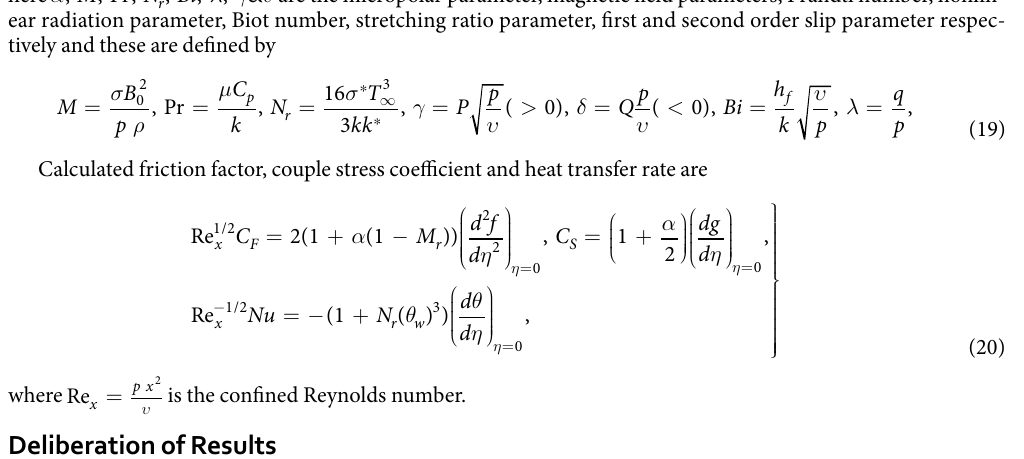
g (0), (0) but a contrary development is noticed for second order slip parameter. Also, the thermal transport rate is a cumulative function of second order slip parameter but an inverse outcome is discerned for γ . Figure 2 renders for the variation of magnetic field parameter ( M ) on the velocity, microrotation and thermal fields. Figure 2(a),(b) divulge that, both the distributions of linear and angular momentum suppresses as the val- ues of magnetic field variable enhances. This contest the physical interpretation on hiring the magnetic force to an electrically conducting fluid, and this provides an elevation in the drag force, which consequences in the decel- erating strength on velocities. Owing to this, a reduction in the fields of velocity and microrotation is noticed. But in case of thermal fields, it’s quite reverse to fluid velocities as exposed in Fig. 2(c). From the plots, it is spotted that both the velocity and the angular velocity are attained maximum due to second order slip and the maximum temperature is noticed for first order